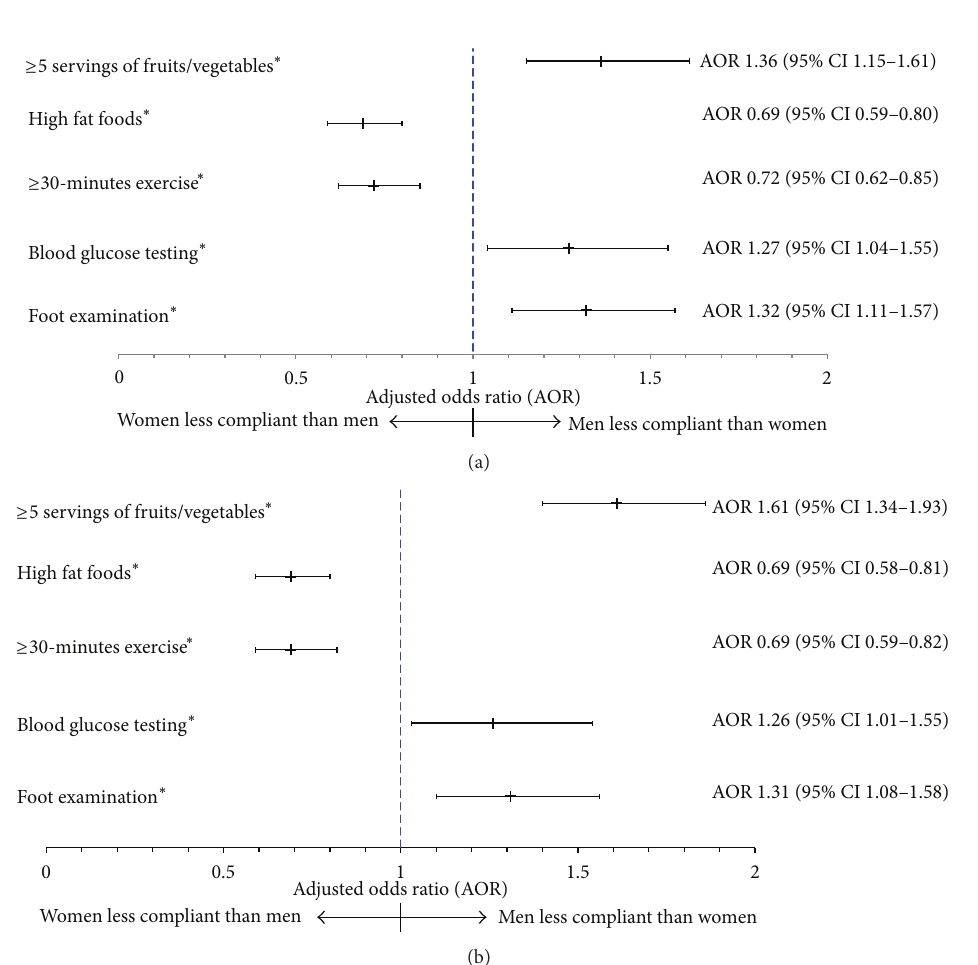
Figure 2: Logisticregression models of compliance with self-care activities for women compared to men in the overall cohort (a) and amongst subjects with at least one diabetic complication (b). Adjusted for age, race/ethnicity, marital status, education, smoking, body mass index, hemoglobin A1c (except model for hemoglobin A1c < 7%), history of hypertension, and major depression. Models in (a) were also adjusted for chronic kidney disease